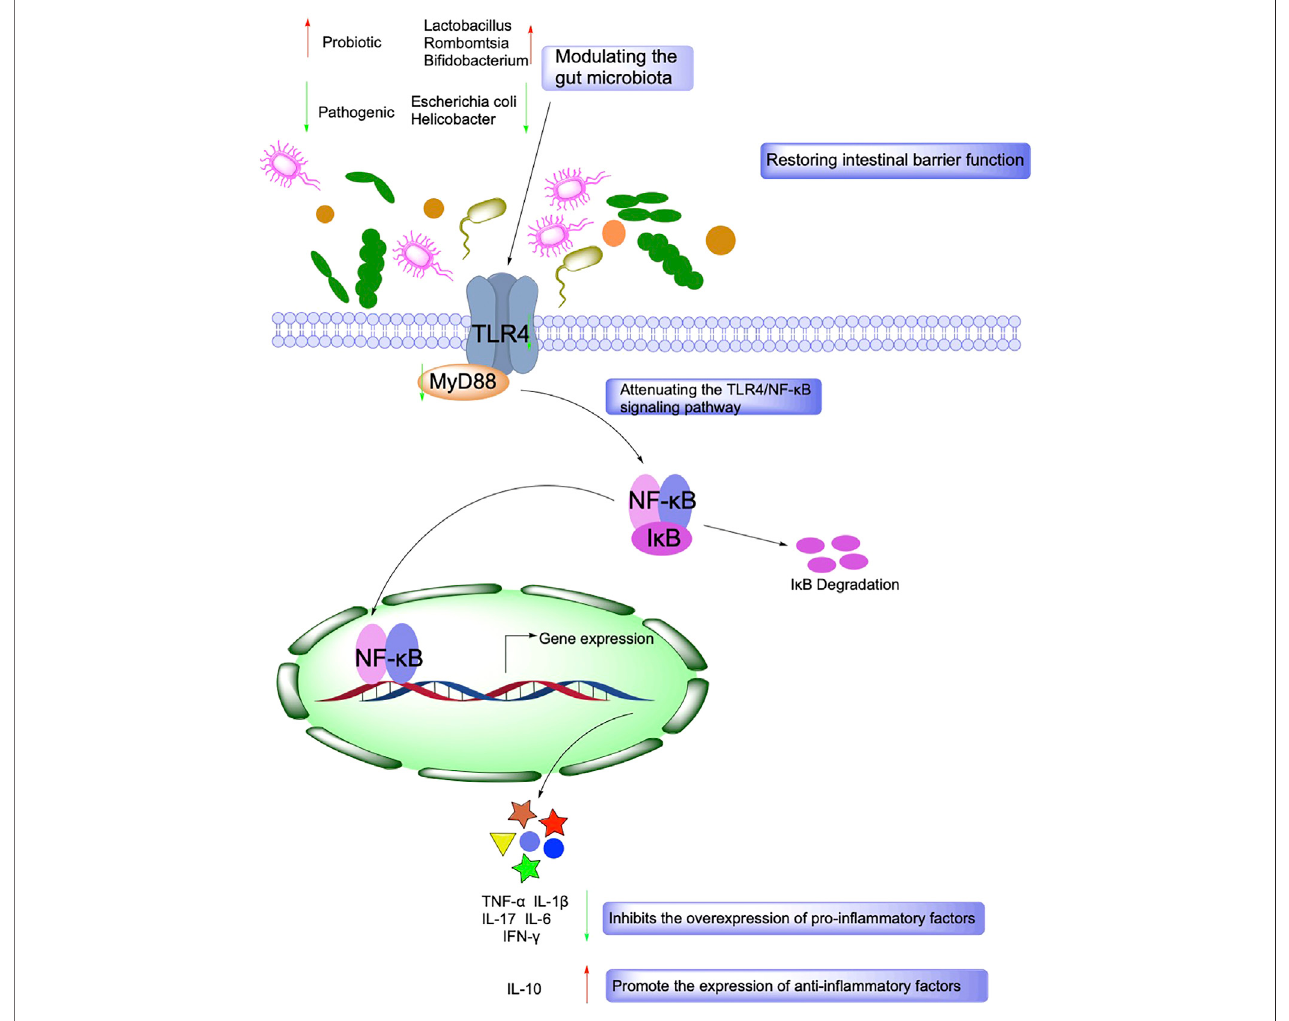
FIGURE 4 | Mechanisms associated with the role of Intestinal barrier function and gut microbiota in IBD.